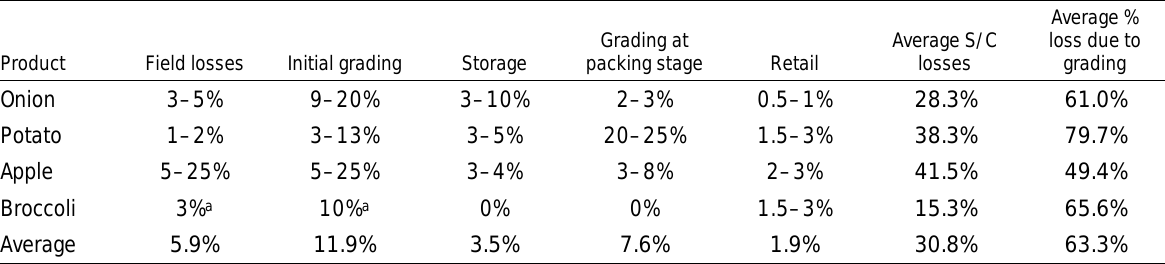
Table 2. Examples of Losses in the UK Fruit and Vegetable Supply Chain (S/C)